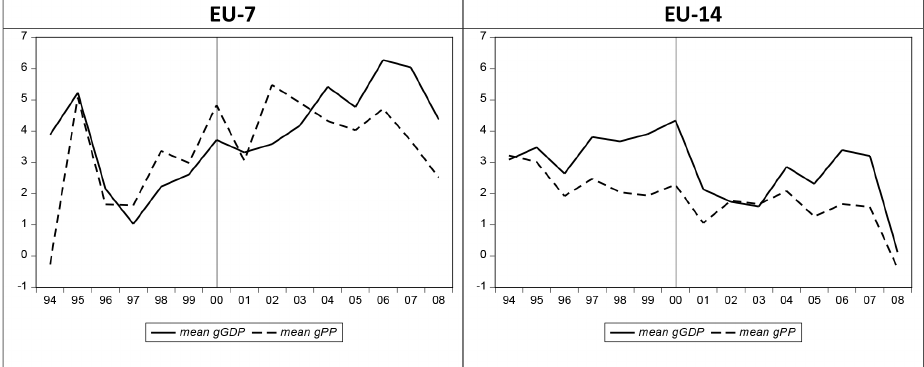
Fig. 1. The mean of GDP and labour productivity growth in the EU-7 and EU-14 countries (in %) Source :